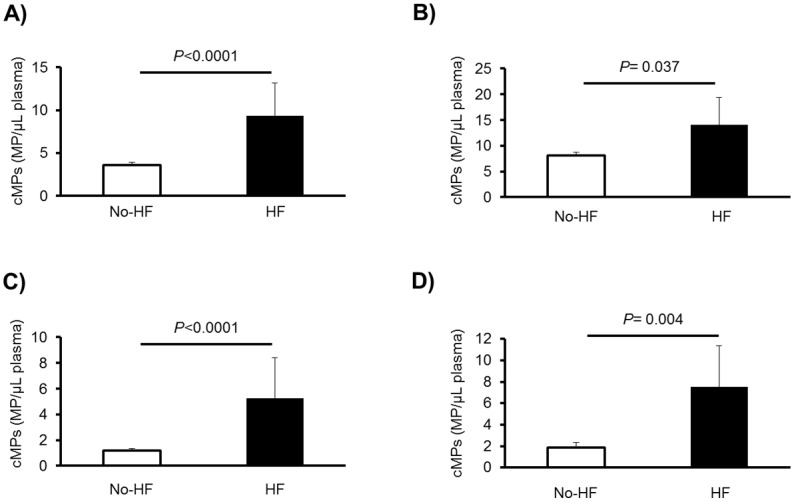
Differences in cMPs between patients who suffered a HF during the AMI and patients who did not.Results are expressed as mean + SEM. P values indicate the differences from one-way ANOVA analyses between patients who suffered a HF during the AMI (HF, n = 17) and patients who did not (No-HF, n = 183). cMPS denote circulating microparticles; HF indicates heart failure; AMI, acute myocardial infarction; PFP, platelet-free plasma; and AV,Annexin V. A) CD61+/CD142+/AV+ cMPs, where CD61 is a biomarker of platelets and CD142, tissue factor; B) CD14+/AV+ cMPs, where CD14 is a biomarker of monocytes; C) CD14+/CD11b+/AV+ cMPs, where CD11b is macrophage-1 antigen (Mac-1); and D) CD14+/CD142+/AV+ cMPs, monocyte-derived cMPs carrying tissue factor.